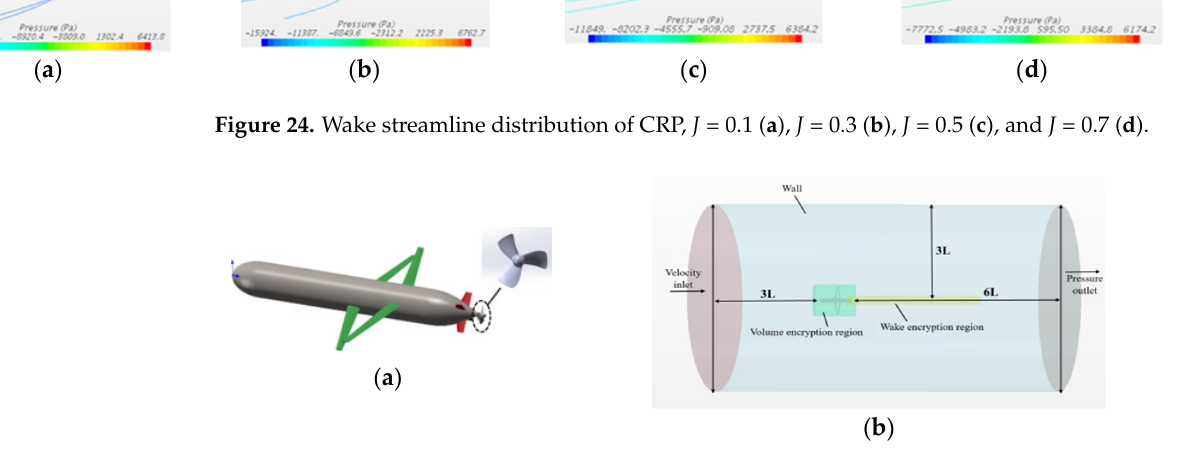
Figure 25. The 3D model ( a ) and the calculation domain ( b ) of the hybrid-driven AUG with the single propeller.